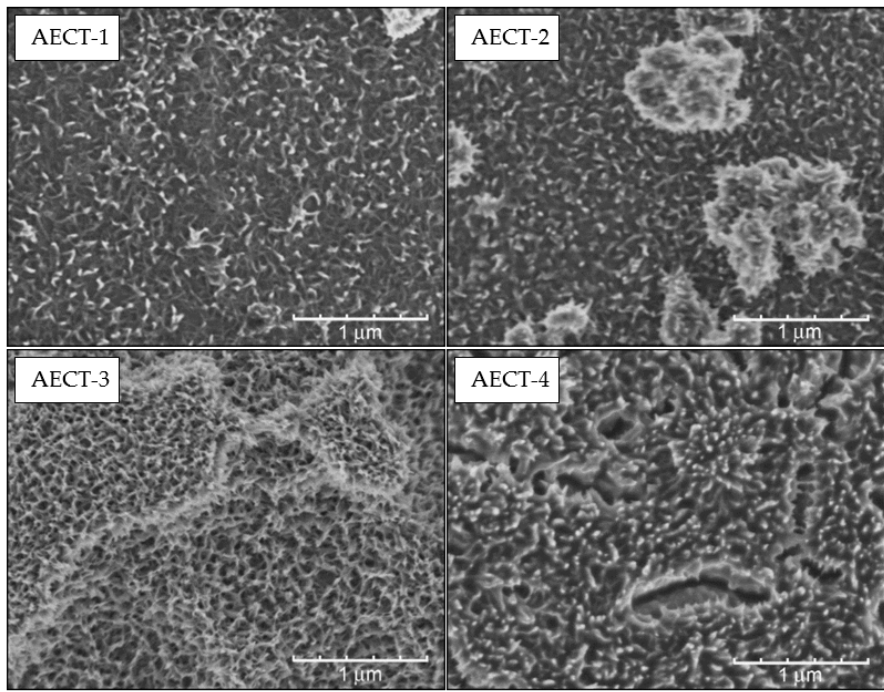
Figure 5. SEM micrographs of the surface of AECT samples at high magnification.